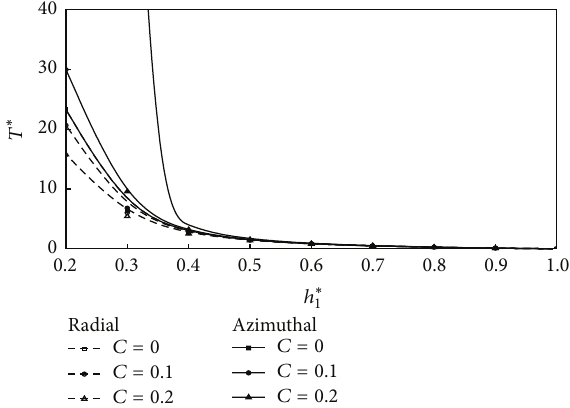
Figure 8: Variation of nondimensional squeeze film time 𝑇 ∗ with ℎ ∗ 1 for different values of